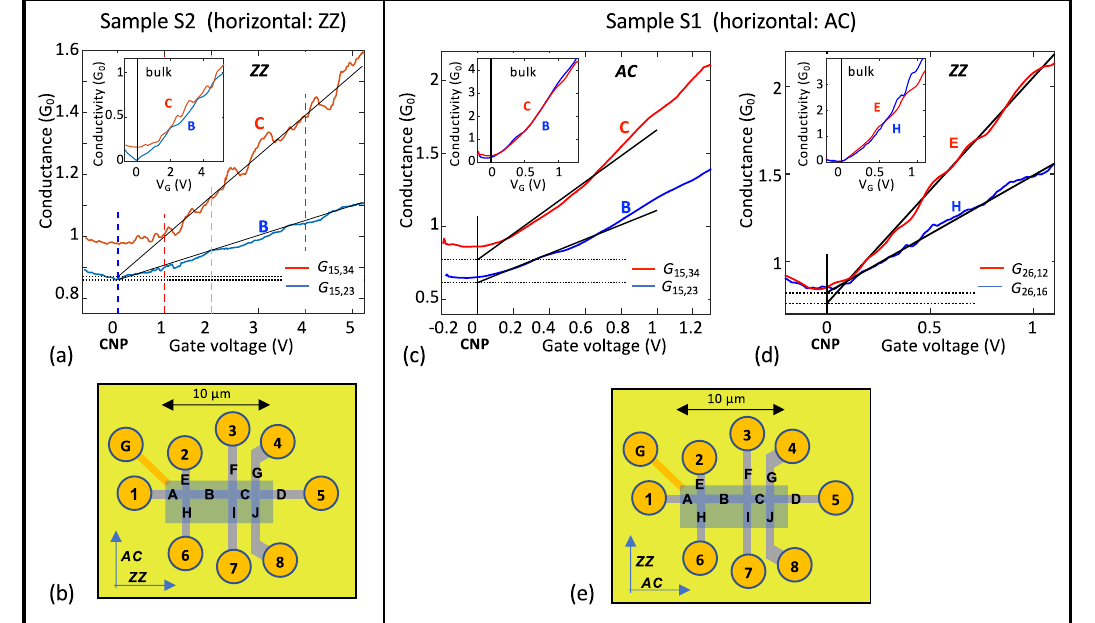
Fig. 3 | Demonstration of the 1 G 0 edge state. a , b Sample S2, axis along ZZ orientation, width = 1 µ m. a 4-point conductances G B , G C ofsegments Band C ( L B = 4.5 µ m, L C =2.5 µ m).Theresidualconductance G res (i.e.theedgestate,dashedlines) isdeterminedfromextrapolationof G (V G )toV G =0(blacklines)fromwhichwe fi nd γ ZZ >50 µ m.Seetextfordiscussionofcontactresistancesandjunctionresistances. Inset shows that the bulk conductance σ ZZ for segments B and C are essentially identical, asexpected. b Schematic diagram of S2: contacts (gold),segments (bold letters),andgate(bluerectangle).Ungatedgrapheneribbonsectionshaveacharge